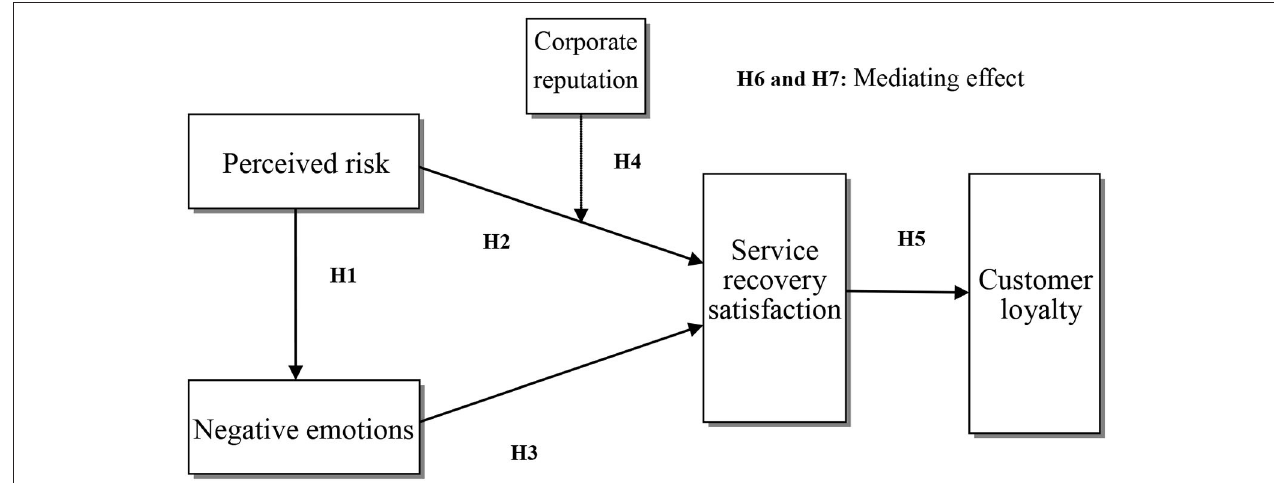
FIGURE 1 | Research